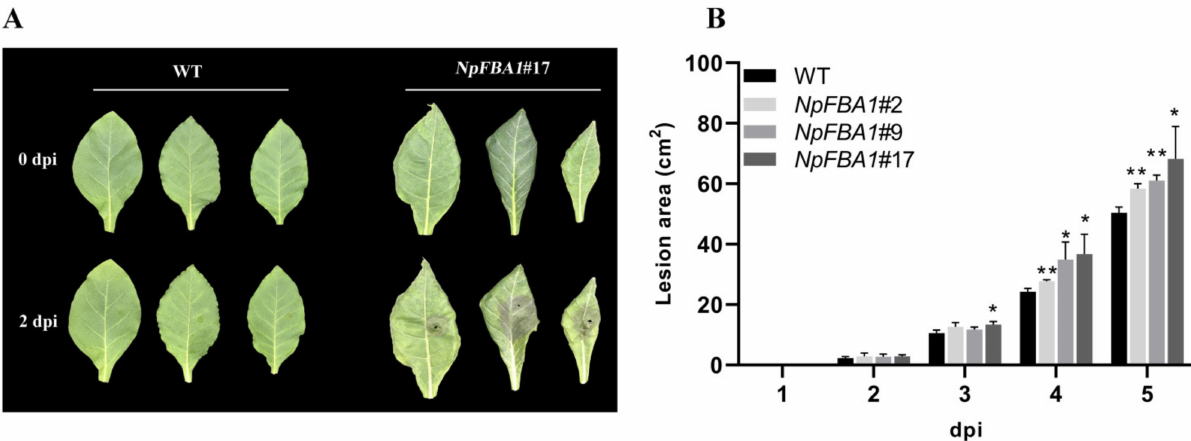
Figure 7. Effects of NpFBA1 on tobacco resistance to P. parasitica . ( A ) Leaf damage in the WT and transgenic lines at 0 and 2 days after P. parasitica infection. ( B ) Bar plot of leaf disease spot area from 0 to 5 days for the WT and transgenic lines. dpi, Days post inoculation. Asterisks indicate significant differences between WT and transgenic plants, * p < 0.05, ** p < 0.01, by Student’s t -test, number of samples, n =